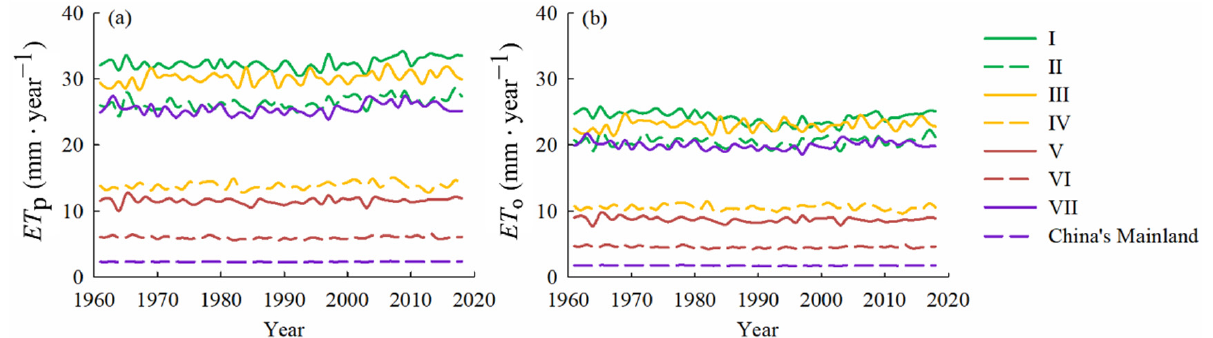
Figure 7. The temporal variations in annual variables in different sub-regions of China. The sub- regional ET p and ET o values were computed using the site-specific weight coefficients obtained from the Theson-polygon method in ArcGis. ( a ) ET p and ( b ) ET o